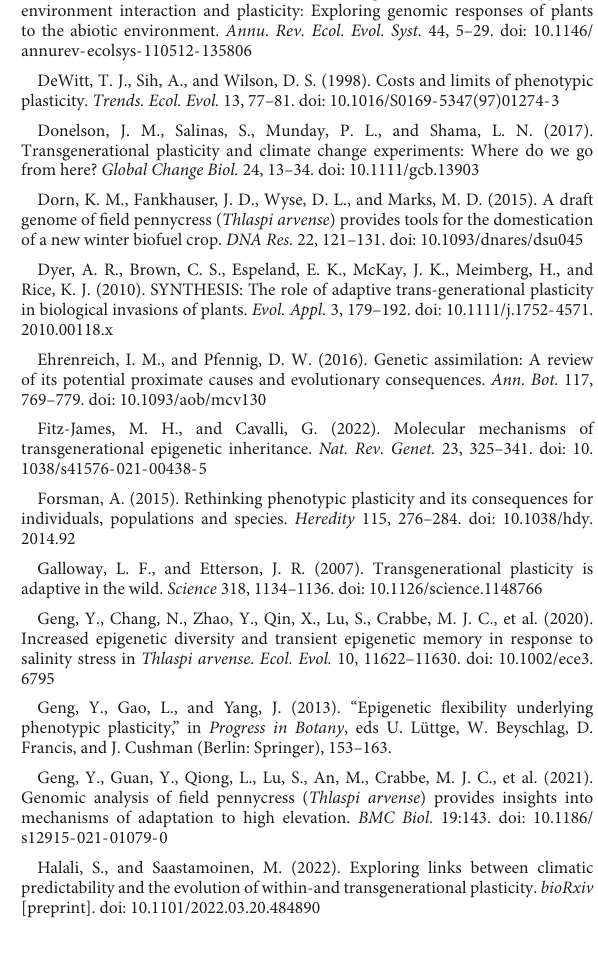
SUPPLEMENTARYFIGURE1 Gene co-expression network construction. (A) Clustering dendrogram of genes with the original module colors and assigned merged module colors. (B) Soft threshold of network construction. Power = 16 was selected. SUPPLEMENTARYFIGURE2 The medianRank preservation statistics (A) and the Zsummary preservation statistics (B) of the modules. The dashed blue and green lines indicate the thresholds of 2 < Zsummary <